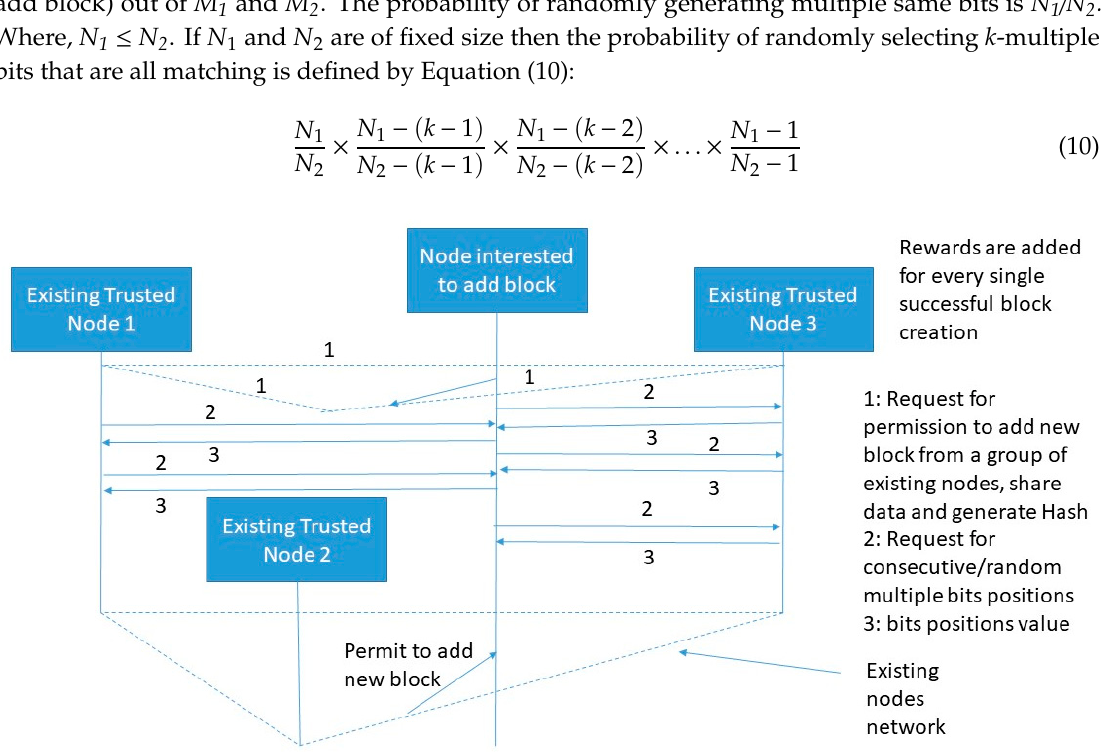
Figure 8. Proposed multi-player multi-bits (MPMB) PoG consensus algorithm.